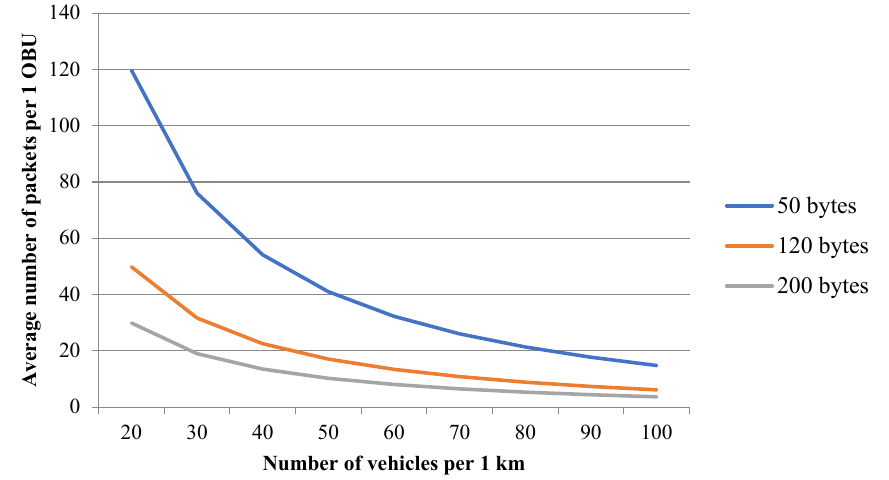
Figure 9. Average number of packets per OBU when using confidentiality level Figure 8. Average number of packets per OBU when using confidentiality level 2.